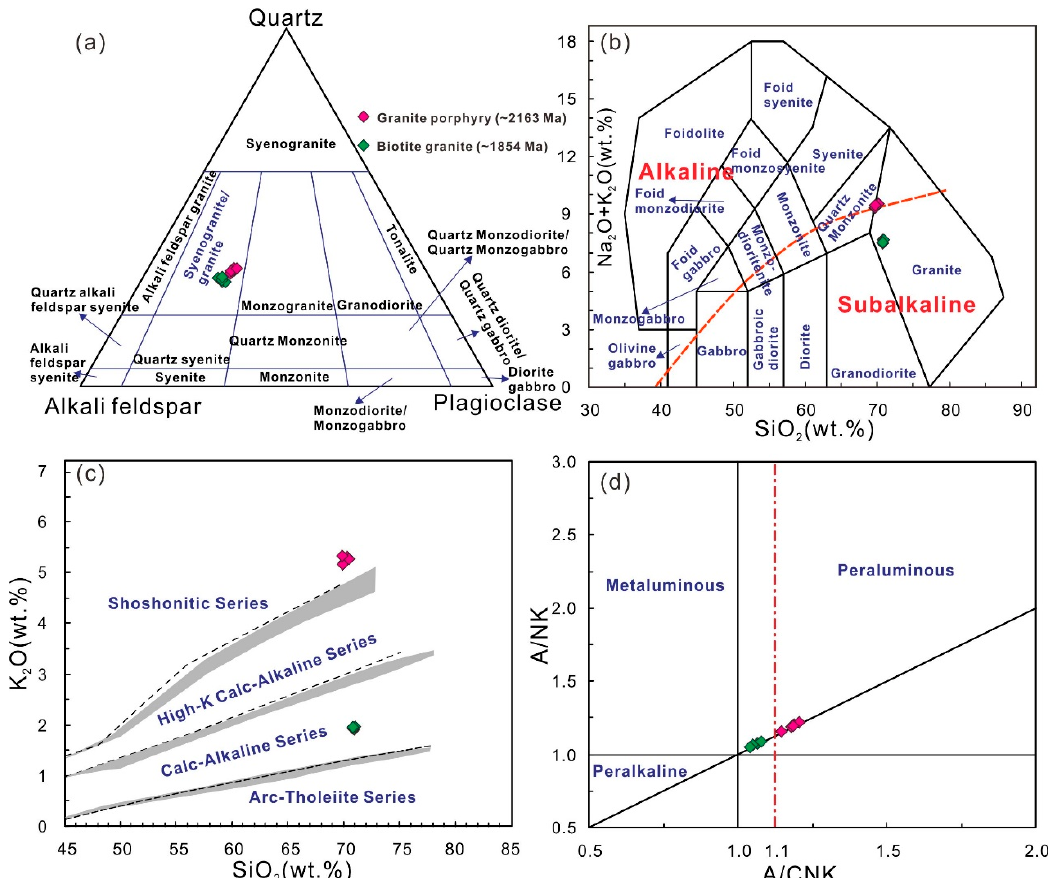
Figure 6. Major element geochemical diagram of igneous rocks in Qingchengzi district. ( a ) Modal quartz–alkali feldspar–plagioclase classification (after Le Maitre [52]); ( b ) total alkali (Na 2 O + K 2 O) vs. SiO 2 (after Irvine and Baragar [53]); ( c ) K 2 O vs. SiO 2 (after Peccerillo and Taylor [54]); and ( d ) A/NK vs. A/CNK (after Maniar and Piccoli [55]).